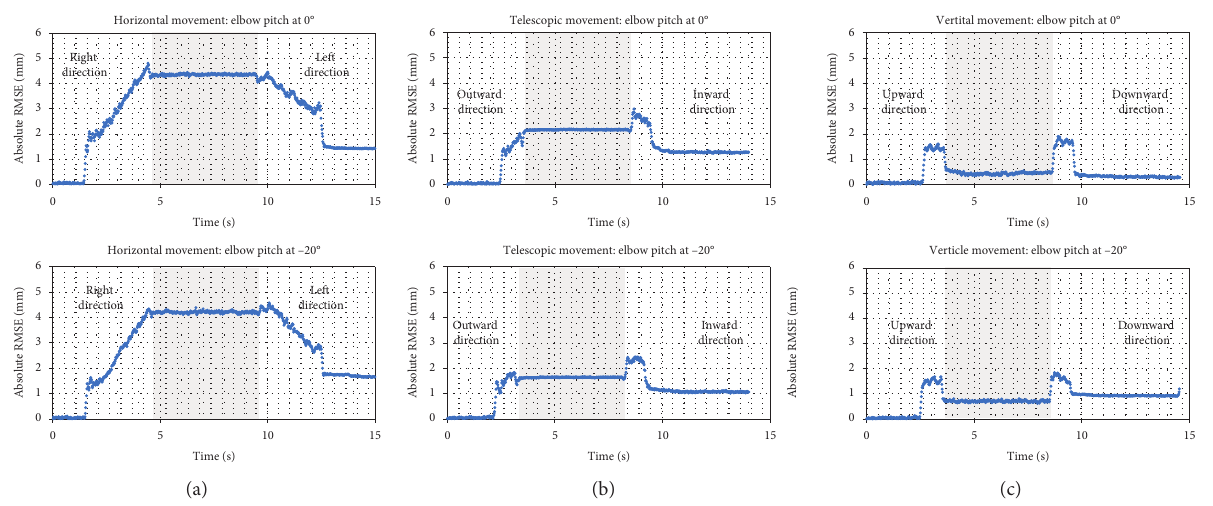
Figure 6: RMS error in vertical, horizontal, and telescopic directions due to parasitic movements.